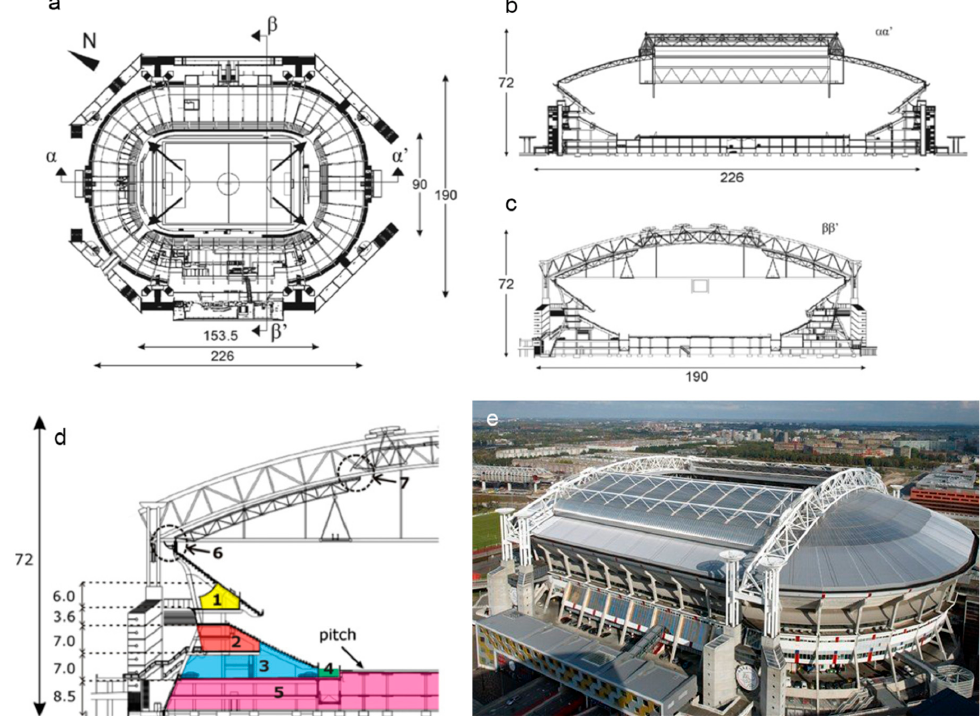
Figure 2. The case study stadium Johan Cruyff Arena. ( a ) Horizontal cross-section at a height of 2 m above the ArenA deck. ( b ) Vertical cross-section αα ’. ( c ) Vertical cross-section ββ ’. ( d ) Vertical cross-section of the eastern part of the stadium. ( e ) External view of the stadium with the open roof [11,13].